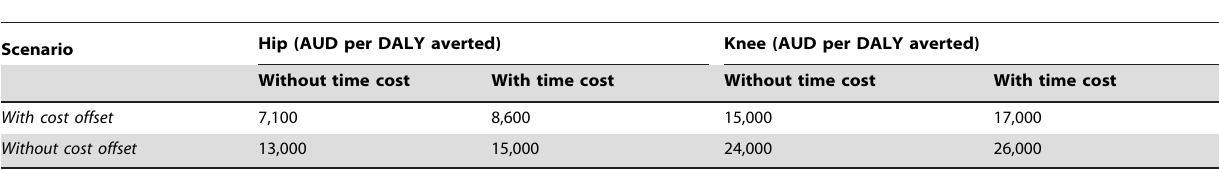
Table 9. Incremental cost-effectiveness ratio including future unrelated health care